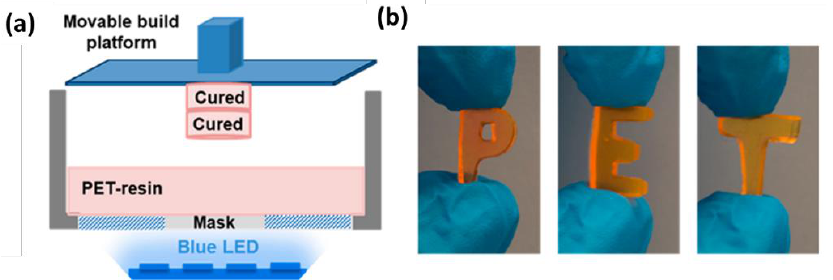
Figure 14. Schematic representation of ( a ) 3D printing process using a bottom-up DLP printer under blue LED light and ( b ) the optical images obtained by the printing process. Reproduced with permission from ref. [93].